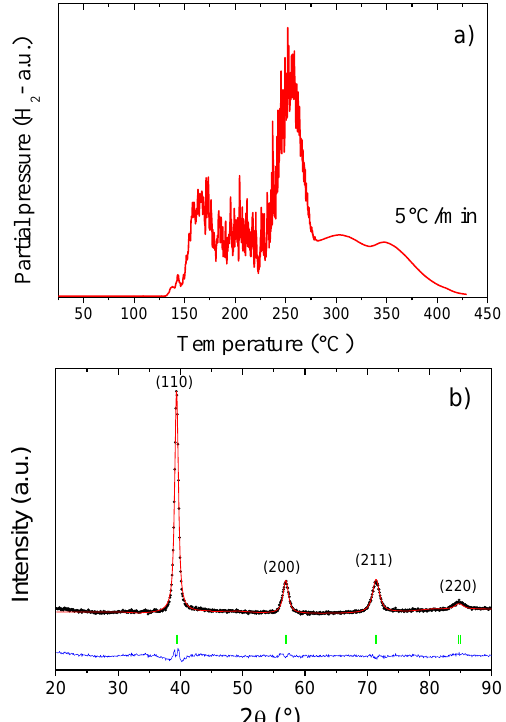
Figure 6. ( a ) TDS profile for the hydrogen desorption from Ti 0.30 V 0.25 Zr 0.10 Nb 0.25 Mo 0.10 D 2 . ( b ) XRD ( λ = 1.5406 Å ) of the Ti 0.30 V 0.25 Zr 0.10 Nb 0.25 Mo 0.10 D 2 after desorption with the corresponding Rietveld anal- ysis.